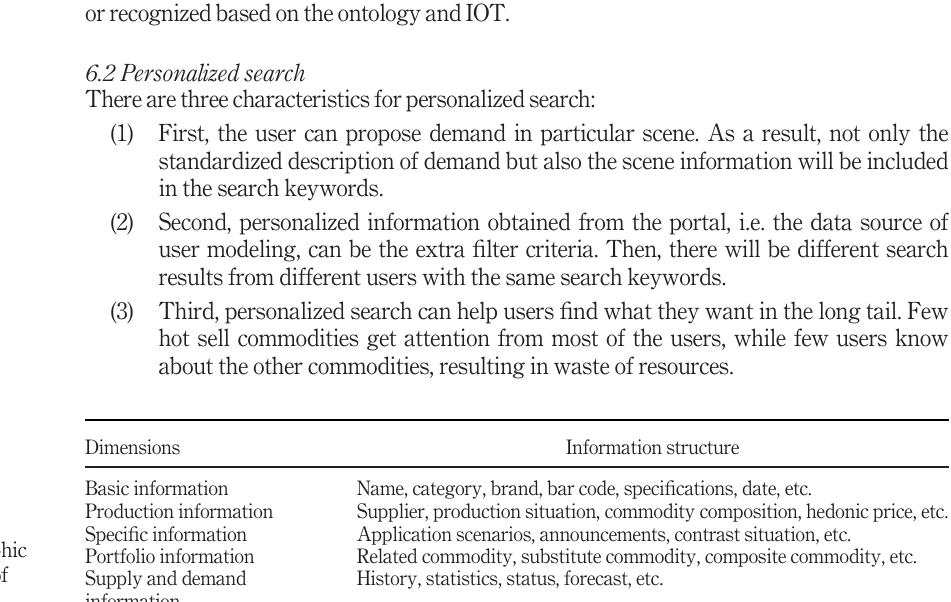
Table III. The holographic information